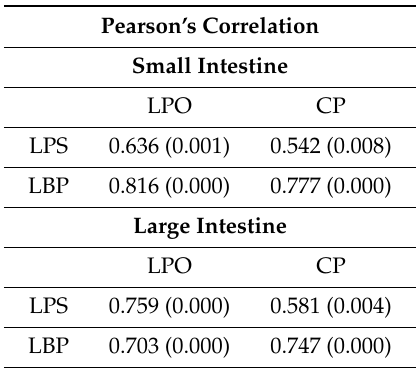
Table 3. Pearson’s correlation between lipopolysaccharide (LPS) of the external gram-negative bacteria wall and the lipopolysaccharide binding protein (LBP) with lipid peroxidation products (LPO)